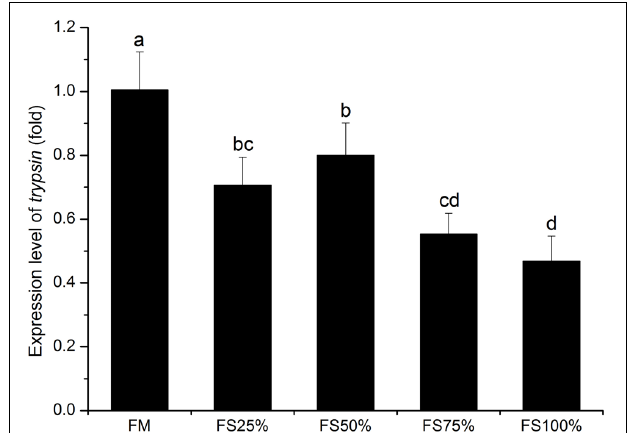
FIGURE 1 | Relative expression level of trypsin in hepatopancreas of white shrimp ( Litopenaeus vannamei ) fed with five different diets. Results are shown as the mean ± SD, and different letters above a bar represent a significant difference ( P < 0.05).